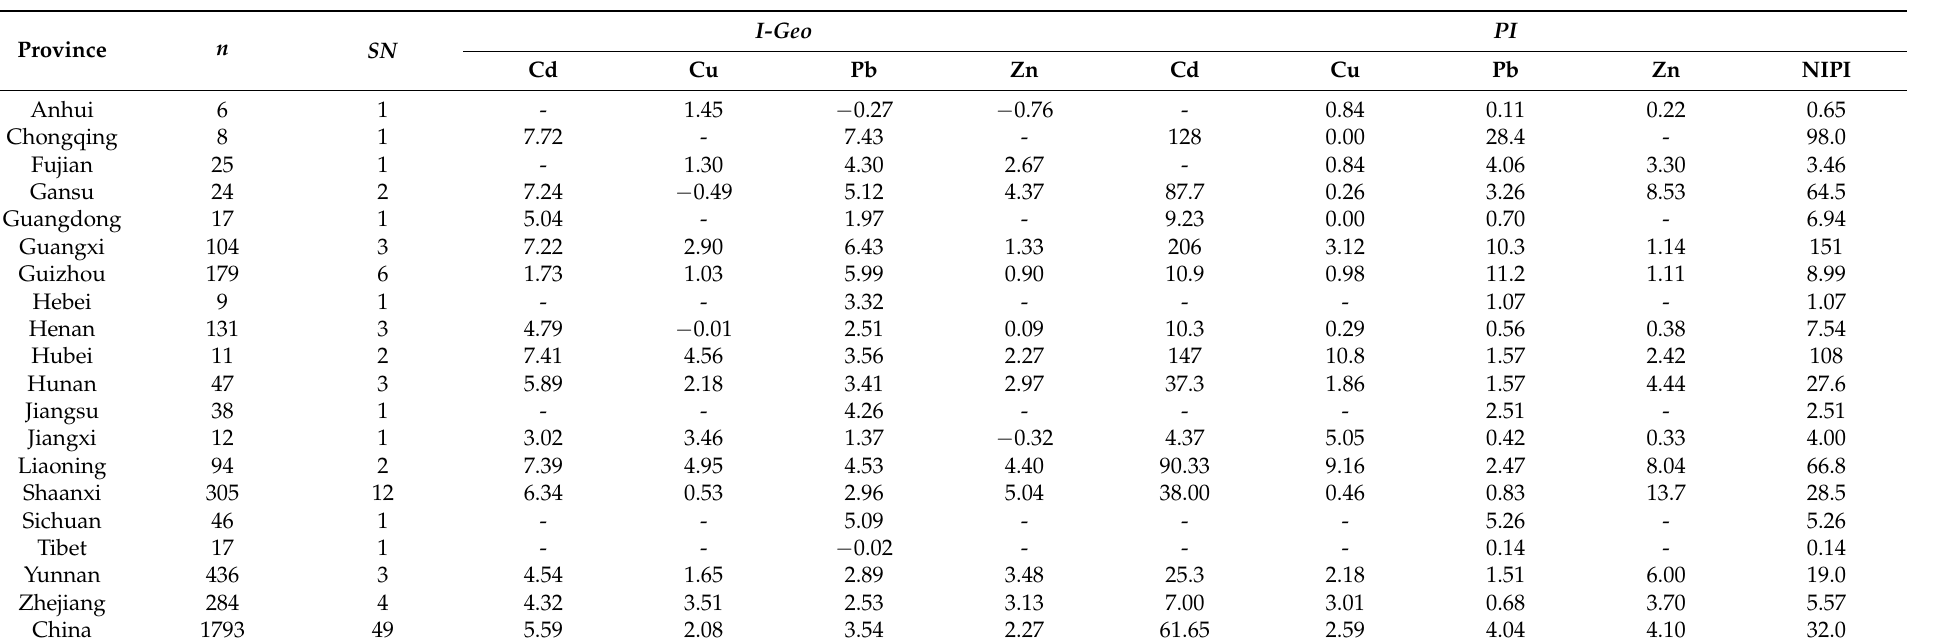
Table 2. Average I-geo values and pollution index ( PI ) with heavy metals in soils around non-ferrous smelteries in China, by province. Reprinted from [41], Copyright (2021), with permission from